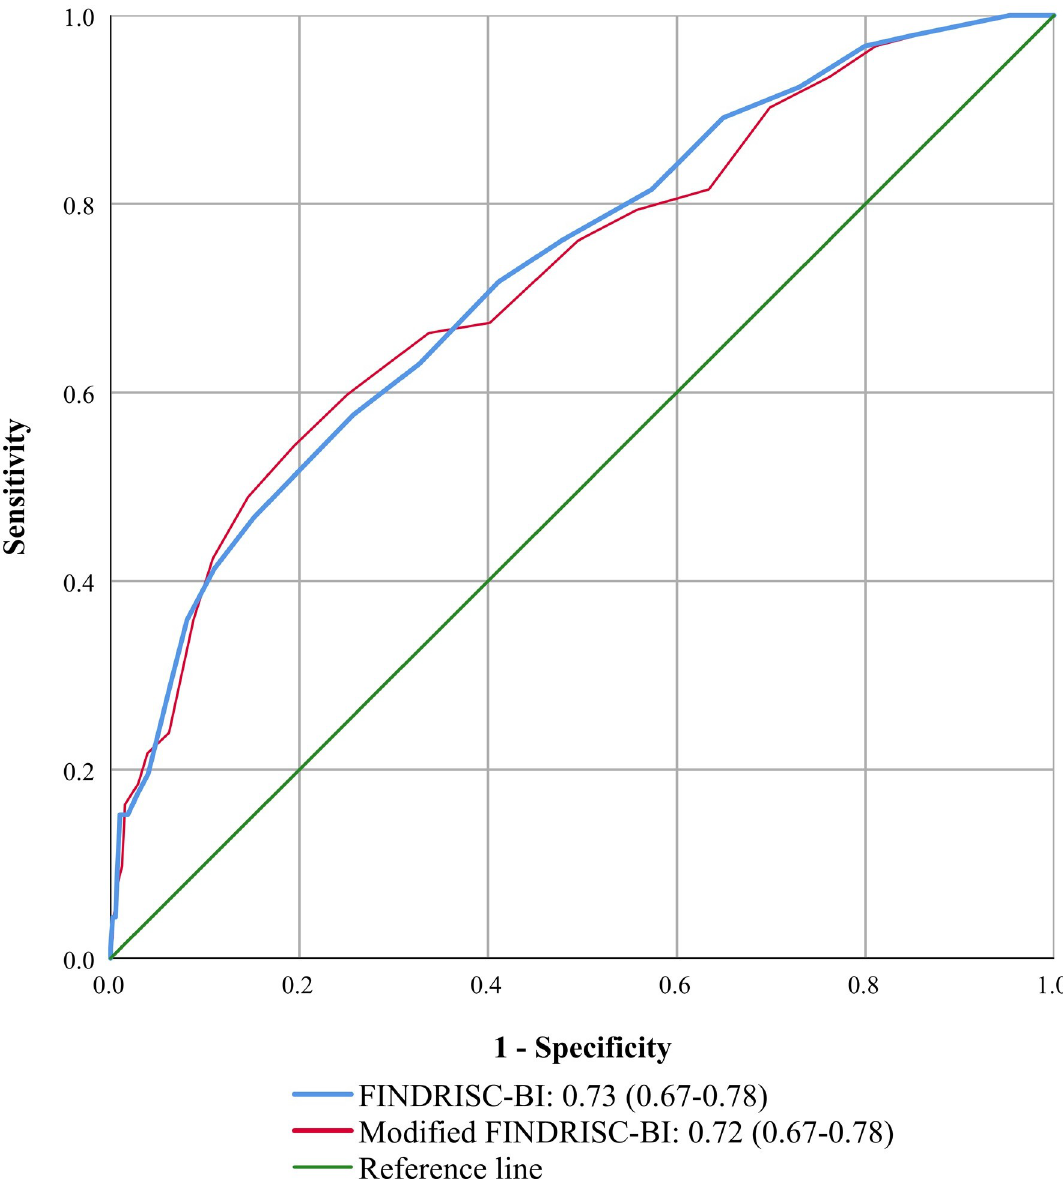
Fig 1. ROC curves for undiagnosed T2DM. FINDRISC-BI: Finnish Diabetes Risk Score-Bahasa Indonesia; T2DM: type 2 diabetes mellitus; ROC curve: receiver operating characteristic curve.